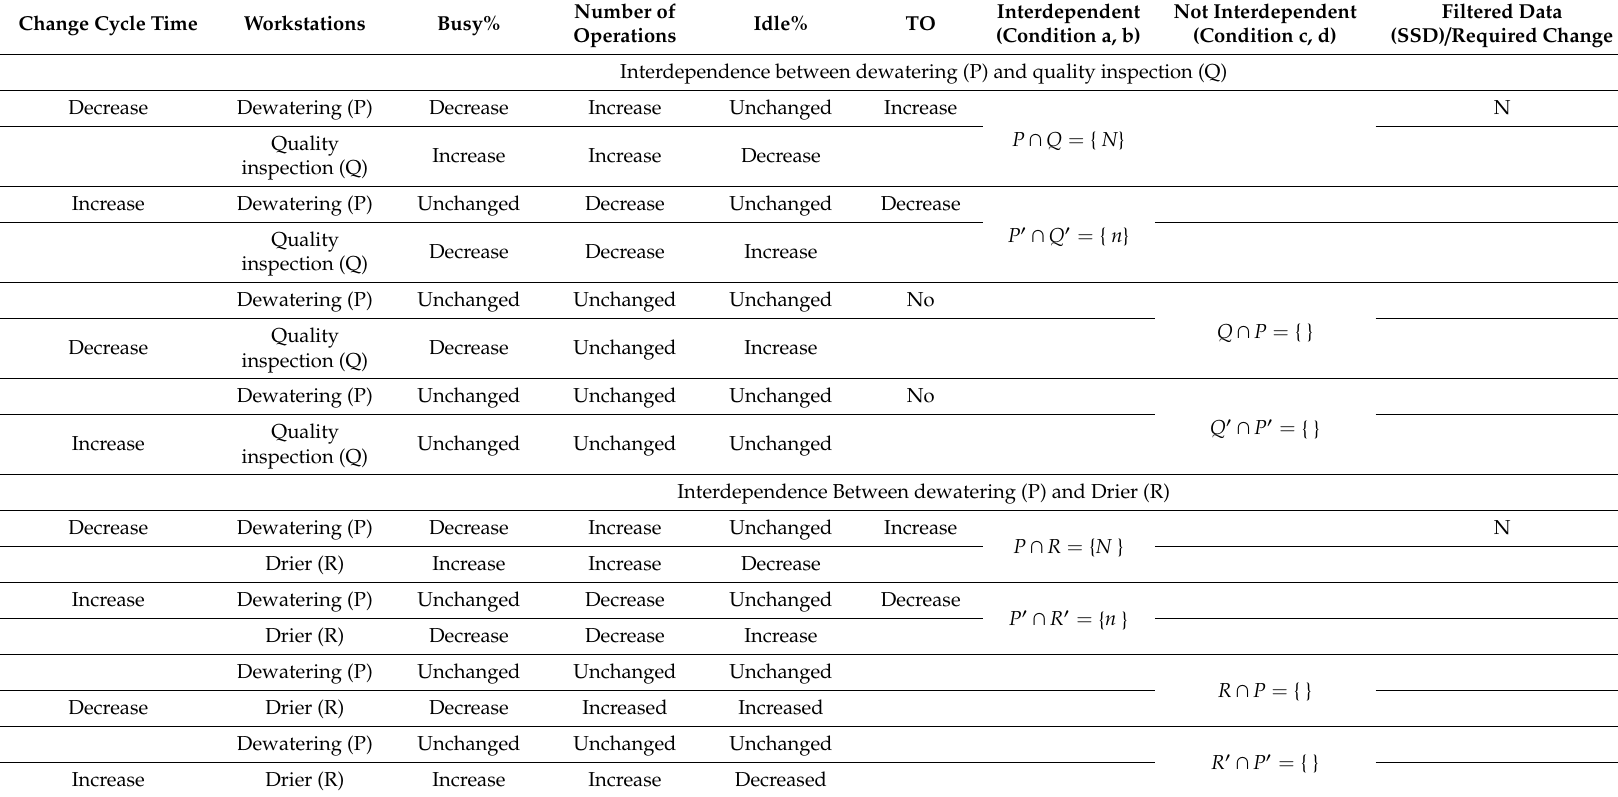
Table 1. Interdependence between the dewatering, quality inspection, and Drying